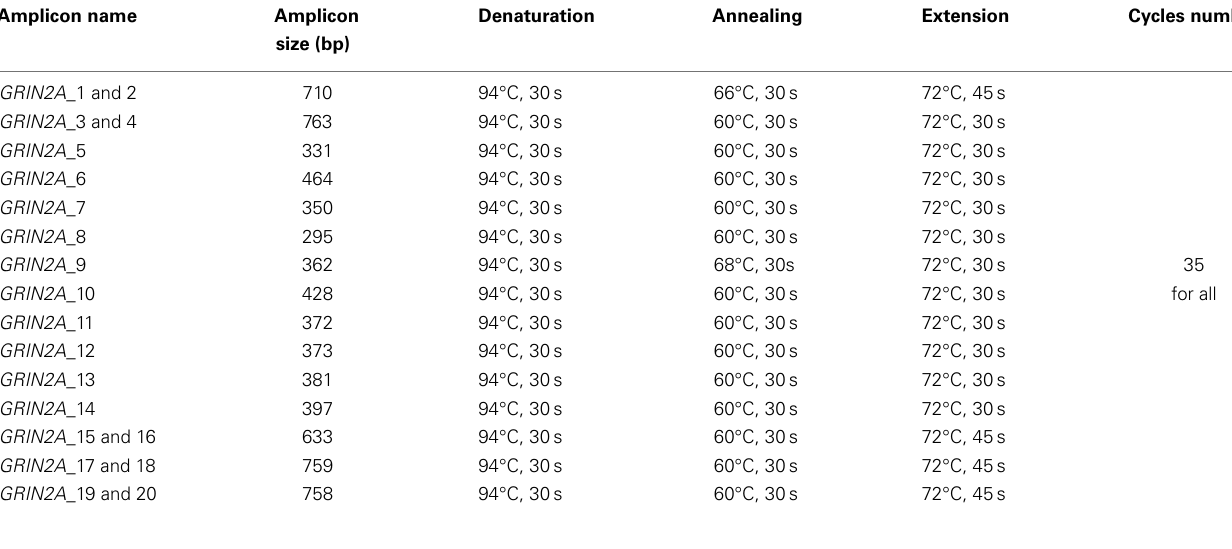
Table 1 | PCR cycling conditions used to amplify GRIN2A sequences